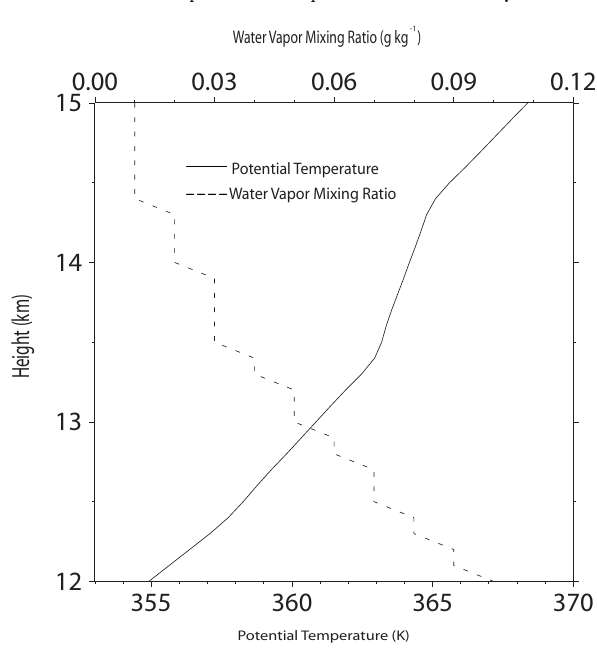
Fig. 1. Vertical profiles of initial potential temperature and water vapor mixing